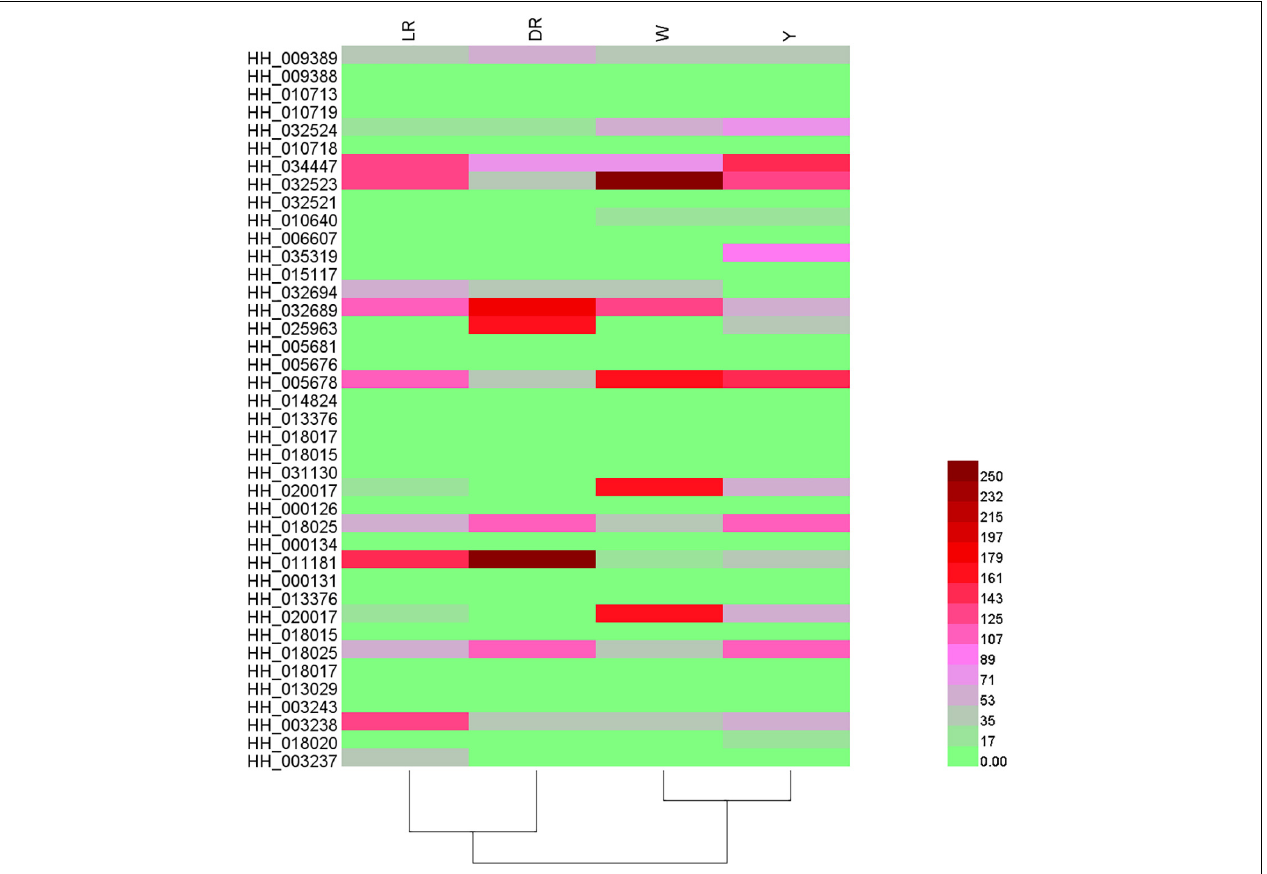
FIGURE 5 | Heatmap of gene expressions of the candidate genes involved in C-glucosylquinochalcones. The heatmap was drawn based on relative expression of the candidate genes involved in C-glucosylquinochalcones biosynthesis. W, white; Y, yellow; LR, light red; DR, deep